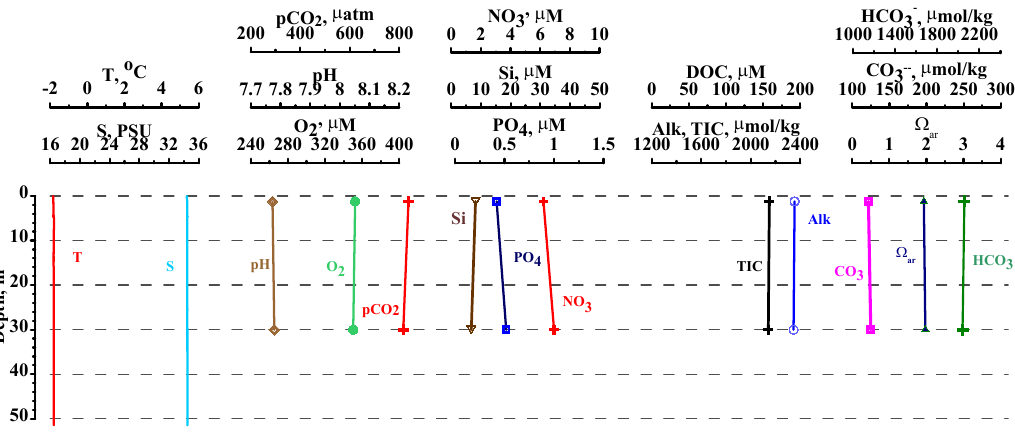
Figure A1. Vertical distribution of physical and chemical parameters at station T4 (19 February 2011).